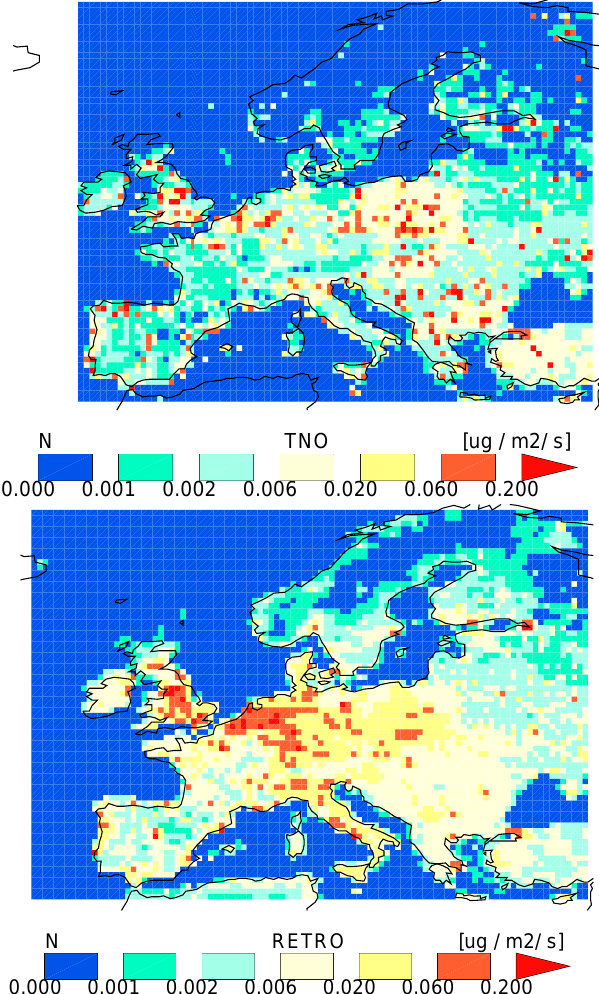
Fig. 1. TNO and RETRO anthropogenic NO x emissions in terms of µgN/m 2 /s presented on a common 0.5 × 0.5 ◦ grid, using a log- normal color scale.